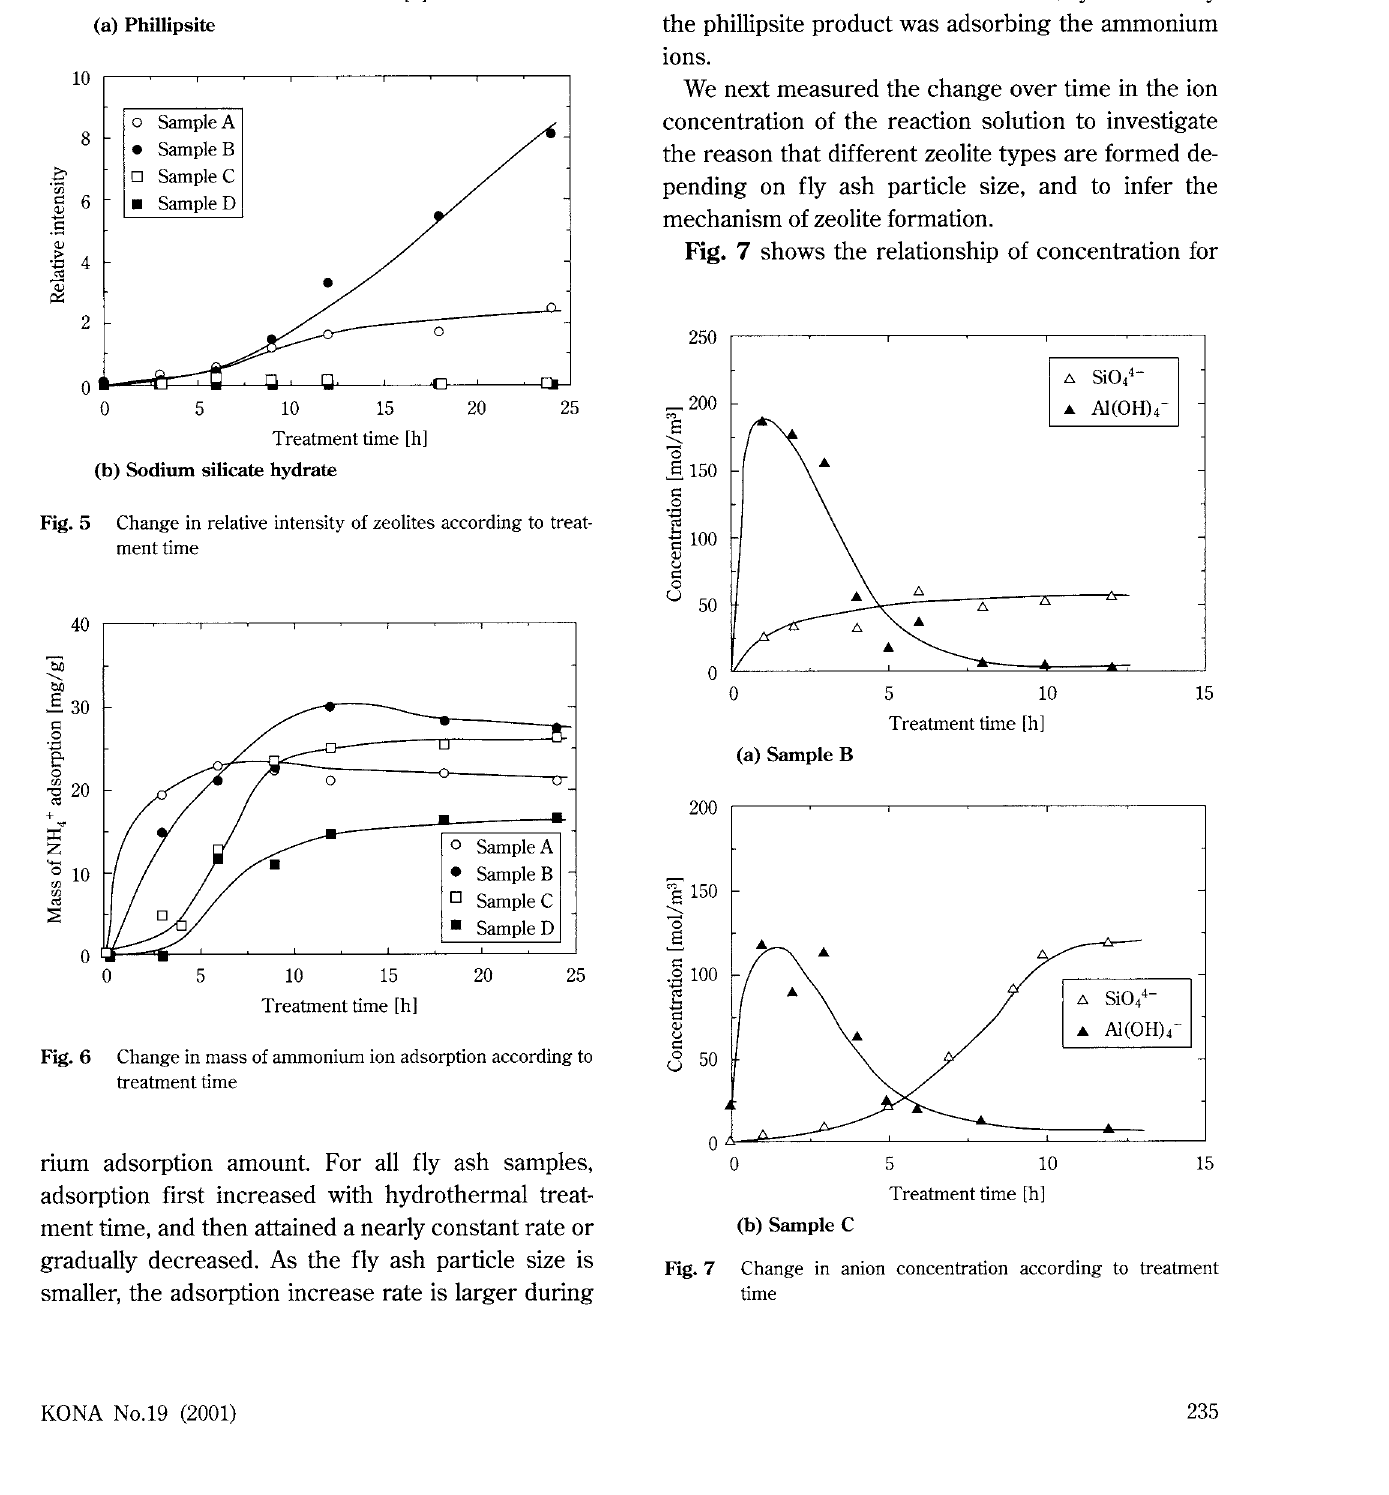
Change in mass of ammonium ion adsorption according to treatment time